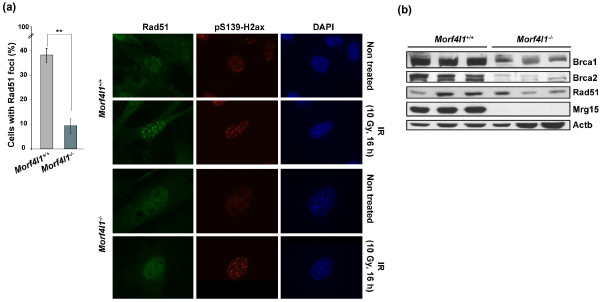
Mrg15 deficiency impairs Rad51 foci formation and reduces Brca1 and Brca2 levels. (a) Left panel: number of cells with Rad51 nuclear foci (>4 foci per nuclei) in wild-type and Morf4l1-/- murine embryonic fibroblast (MEF) clones after (16 hours) treatment with 10 Gy. **Significant difference (two-tailed t test, P < 0.001). Right panel: representative images of Rad51 and pS139-H2ax immunodetection in cultures counted above for foci. DAPI, 4,6-diamidino-2-phenylindole; IR, γ-irradiated. (b) Levels of Brca1, Brca2 and Rad51, and control Actb, in whole cell extracts of Morf4l1-/- MEFs and wild-type counterparts (three cell clones of each genotype are shown).